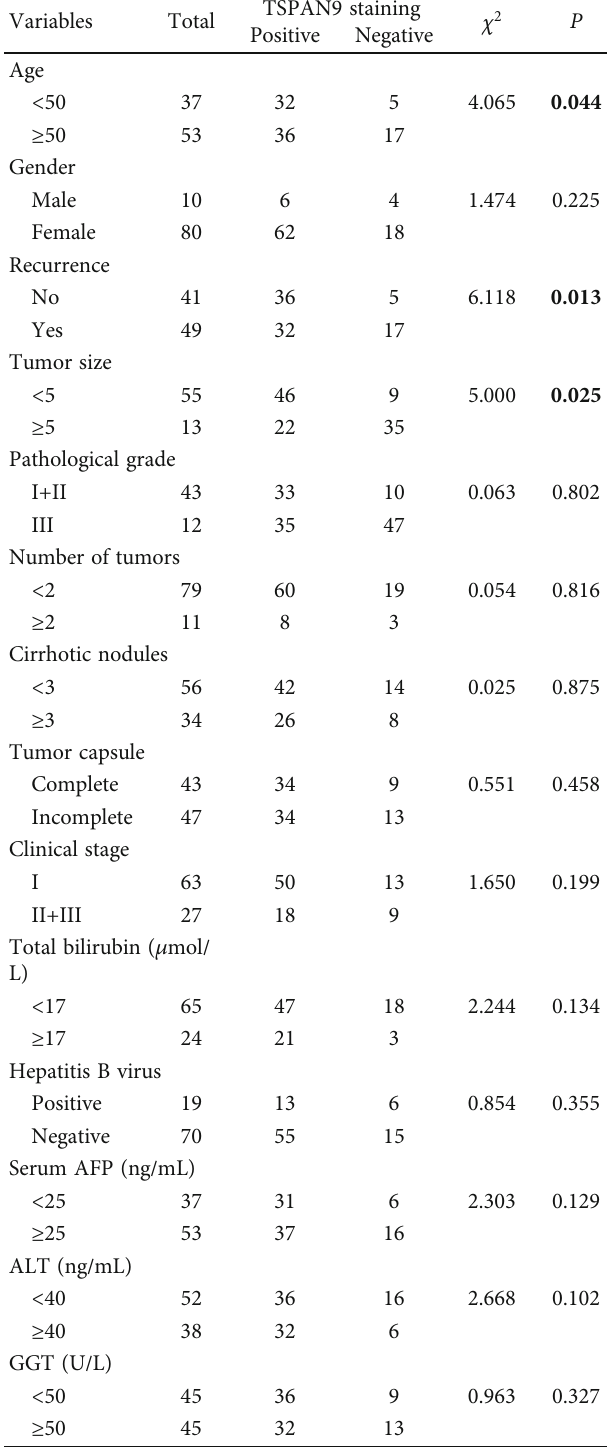
Table 3: COX regression analysis for overall survival of HCC patients after surgery.